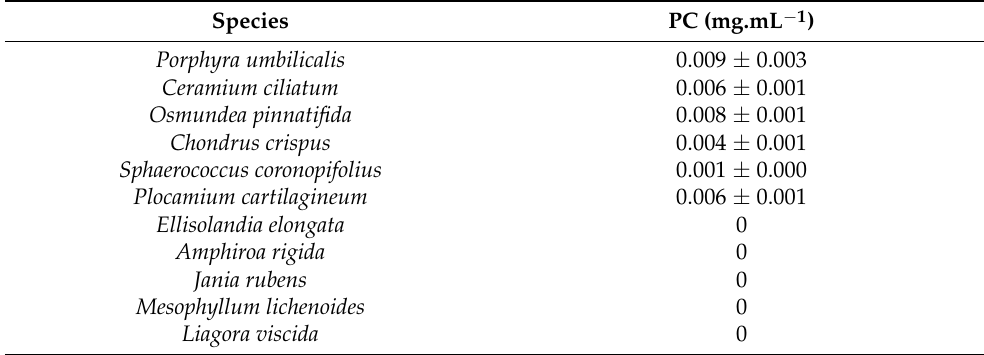
Figure 6. Phycoerythrin concentration of the eleven studied red seaweed species expressed in mg.mL − 1 of fresh weight. PoUm: Porphyra umbilicalis , CeCi: Ceramium ciliatum , OsPi: Osmundea pinnatifida , ChCr: Chondrus crispus , SpCo: Sphaerococcus coronopifolius , PlCa: Plocamium cartilagineum , ElEl: Elisolandia elongata , AmRi: Amphiroa rigida , JaRu: Jania rubens , MeLi: Mesophyllum lichenoides , LiVi: Liagora viscida . Values are presented as means ± SD ( n = 3), and lower-case letters ( a to e ) indicate statistically significant differences in the Tukey HSD test (F(10,32) = 46.407; p = 0.00). Table 2. Pigment concentration (mg.mL − 1 ) of the eleven species presently studied expressed in mean ± standard deviation ( n = 3).